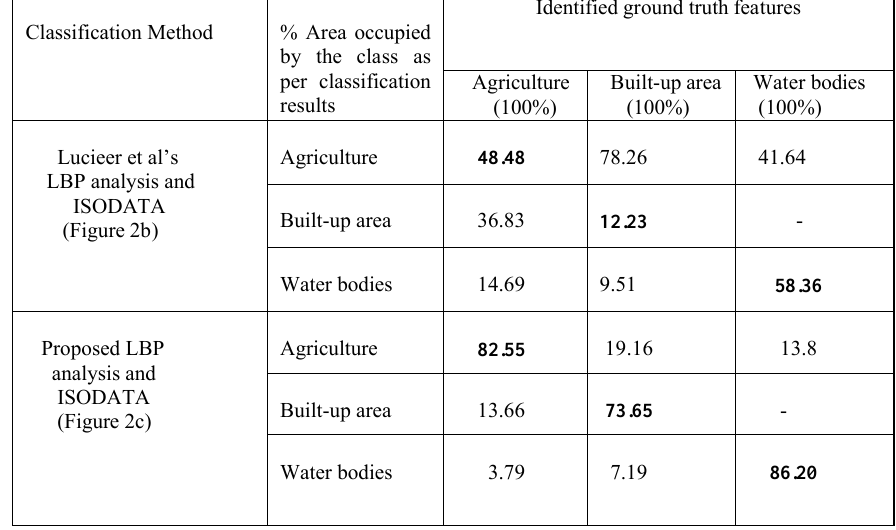
[2005] classification technique and proposed technique - Lucieer et al’s employ a circle of fixed radius ‘c’ from the center pixel position of the kernel and intersected pixels on the perimeter of that circle are only considered for measuring the texture around that pixel. As a result most of the pixels of the kernel are not used for measuring the texture. The proposed method uses a series of circles (2D) centered on the pixel with incremental radius values. The intersected pixels on the perimeter of the circles of radius r (where r = 1, 3 and 5) are considered for measuring the texture around that pixel. As a result it uses more number of pixels of the kernel for measuring the texture around each pixel of the image. - Lucieer et al’s used supervised (fuzzy c-means) classification technique where as the proposed technique an un-supervised (ISODATA) classification